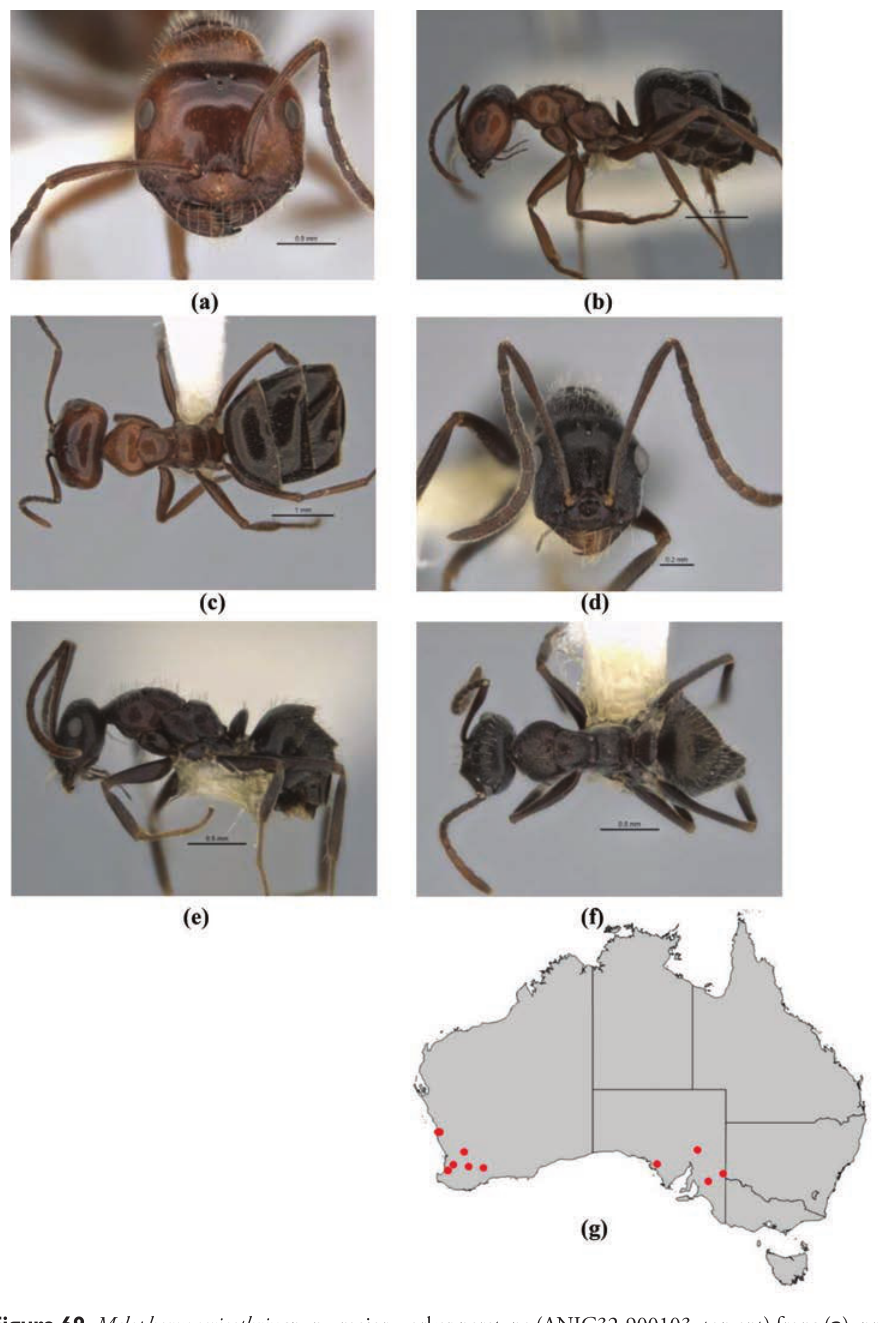
Figure 69. Melophorus sericothrix sp. n.: major worker paratype (ANIC32-900103–top ant) frons ( a ), pro- file ( b ) and dorsum ( c ); minor worker holotype (ANIC32-900174–bottom ant) frons ( d ), profile ( e ) and dorsum ( f ); distribution map for the species ( g ). Low resolution scale bars: 1 mm ( b, c ); 0.5 mm ( a, e, f ); 0.2 mm ( d